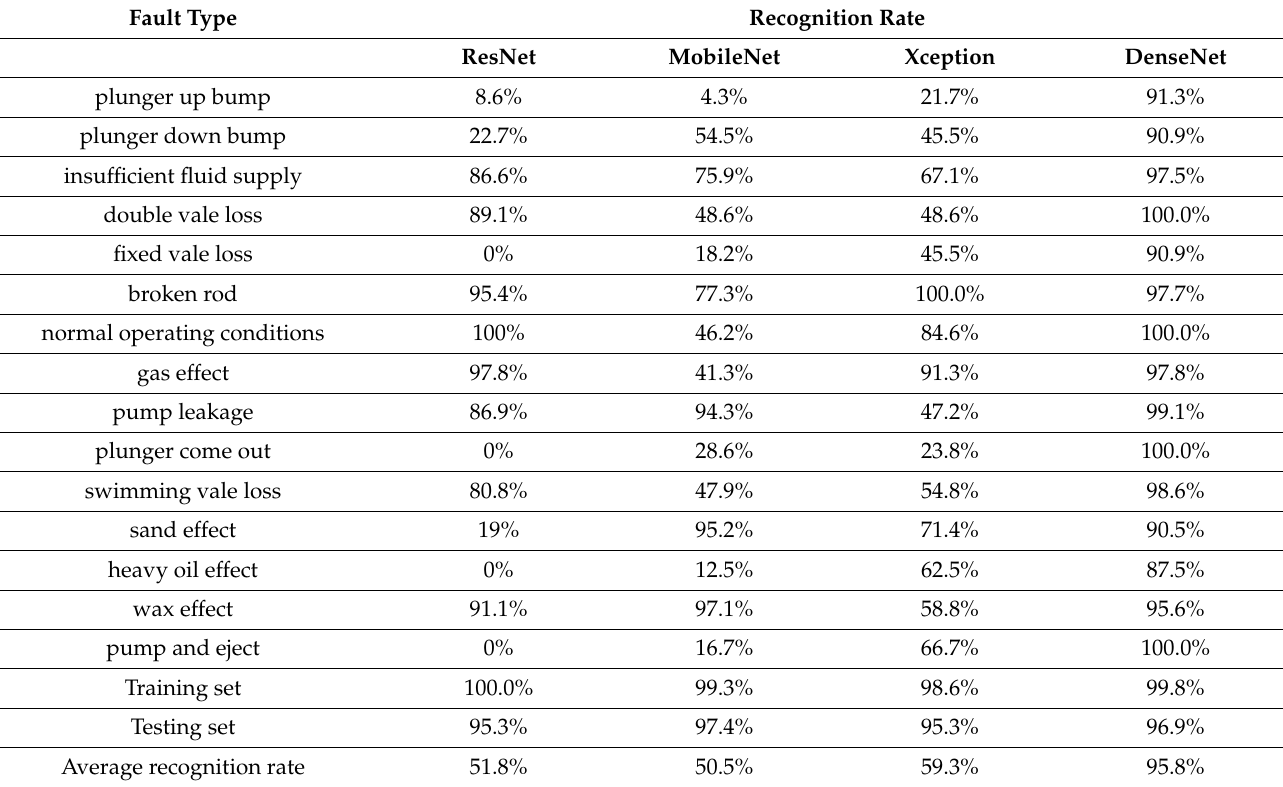
Table 3. Comparison of recognition rate of various